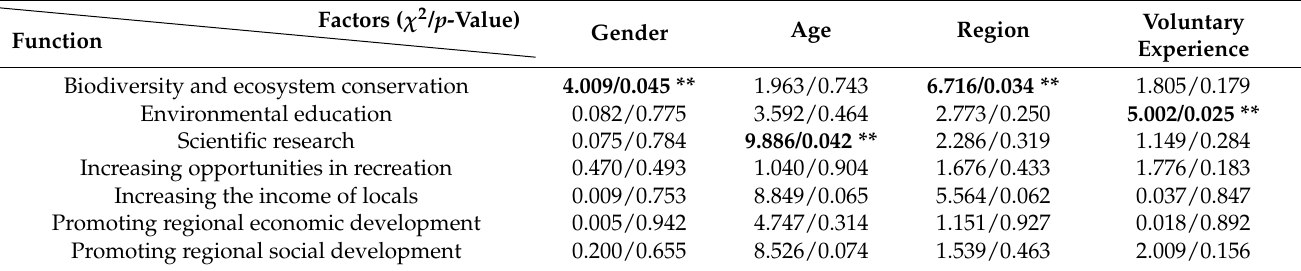
Table 3. Differences in functional ranking choices of the individual demographic